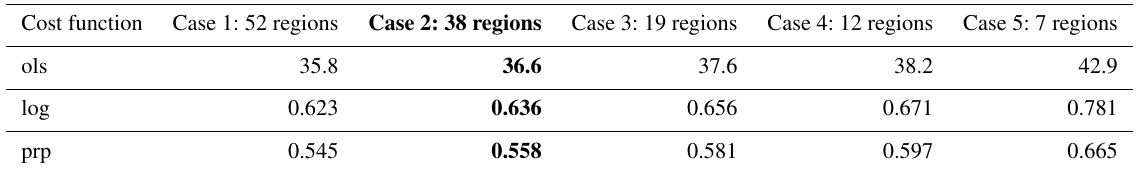
Table 5. Root mean square of residuals after inversions with different numbers of source regions. The standard case with 38 regions is in